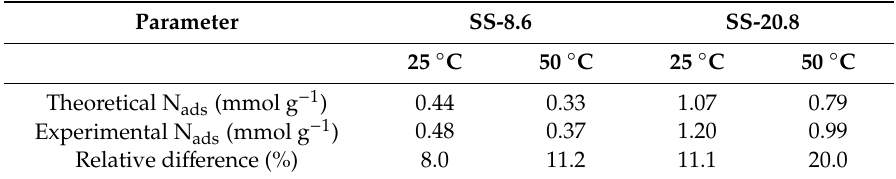
Table 8. Theoretical and experimental values of the CO 2 adsorption capacity at 2.5 MPa, 25 and 50 °C, and mass fractions of 10% and 20%.